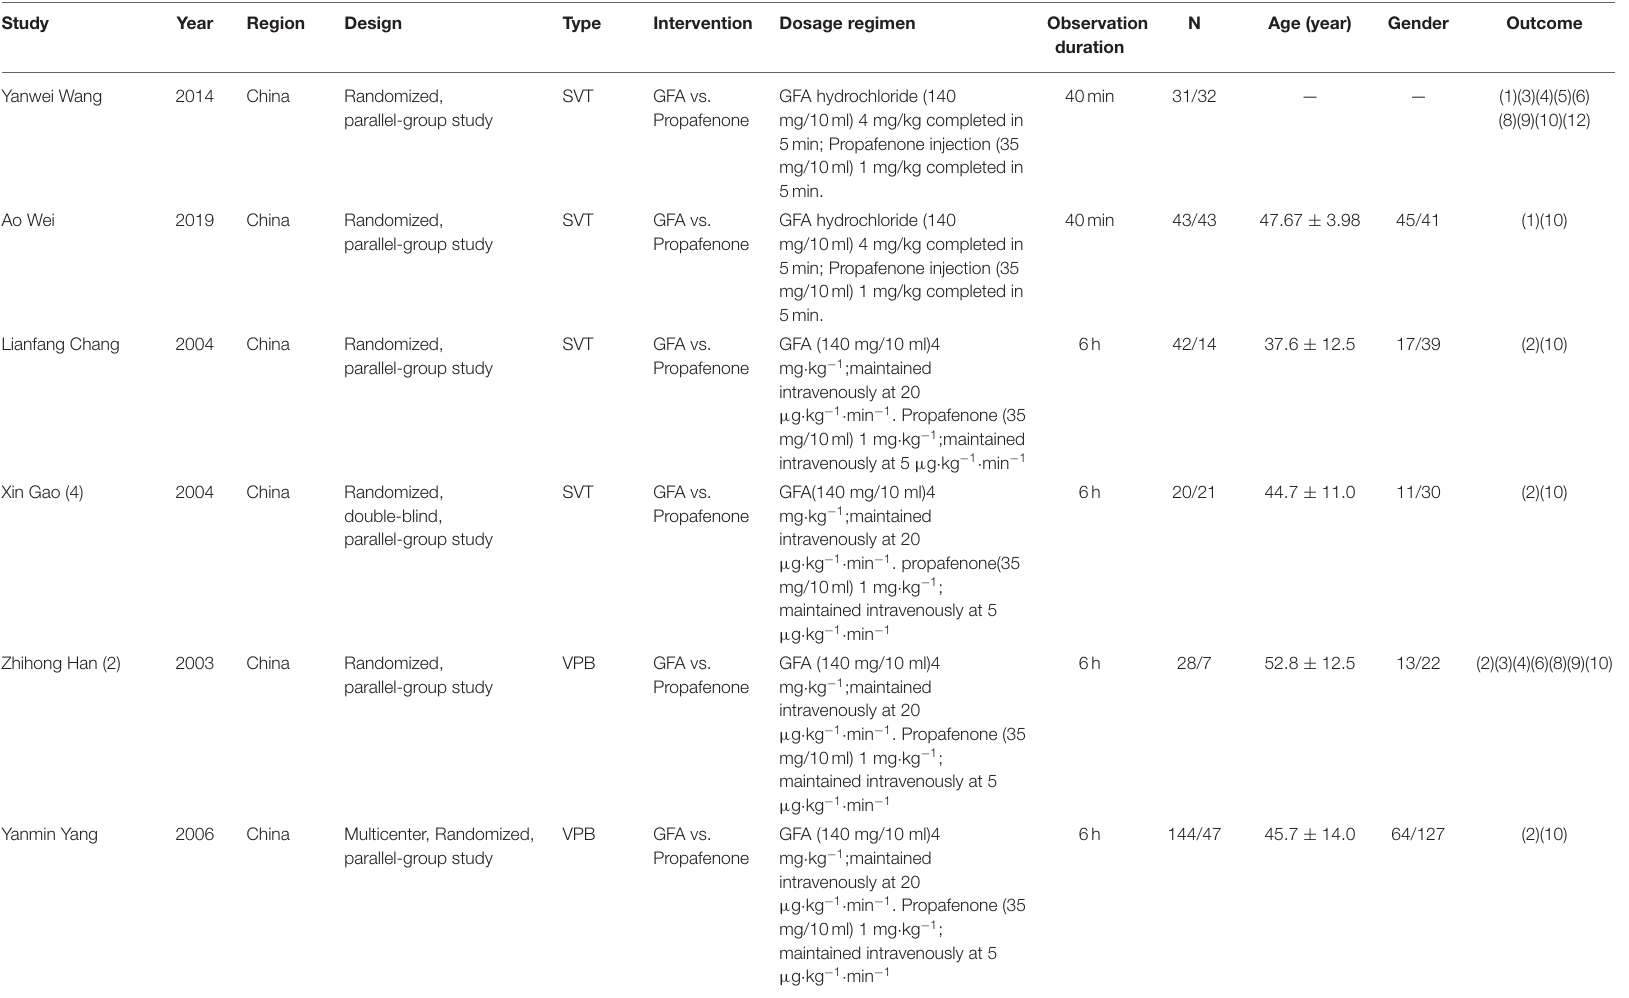
Outcomes: (1) Efficacy (The number of patients with SVT who had reversed in 40min); (2) Efficacy (Number of VPB 6h after drug administration) (3) heart rate; (4) Blood pressure; (5) P-wave; (6) P-R interval; (7) R-R interval; (8) QRS wave complex; (9) QTc interval; (10) Adverse effect; (11) Sinus node recovery time; (12) Mean time of converting; (13) Recurrence rate in 24 h; (14)The number of 15min recurrence; (15) Average